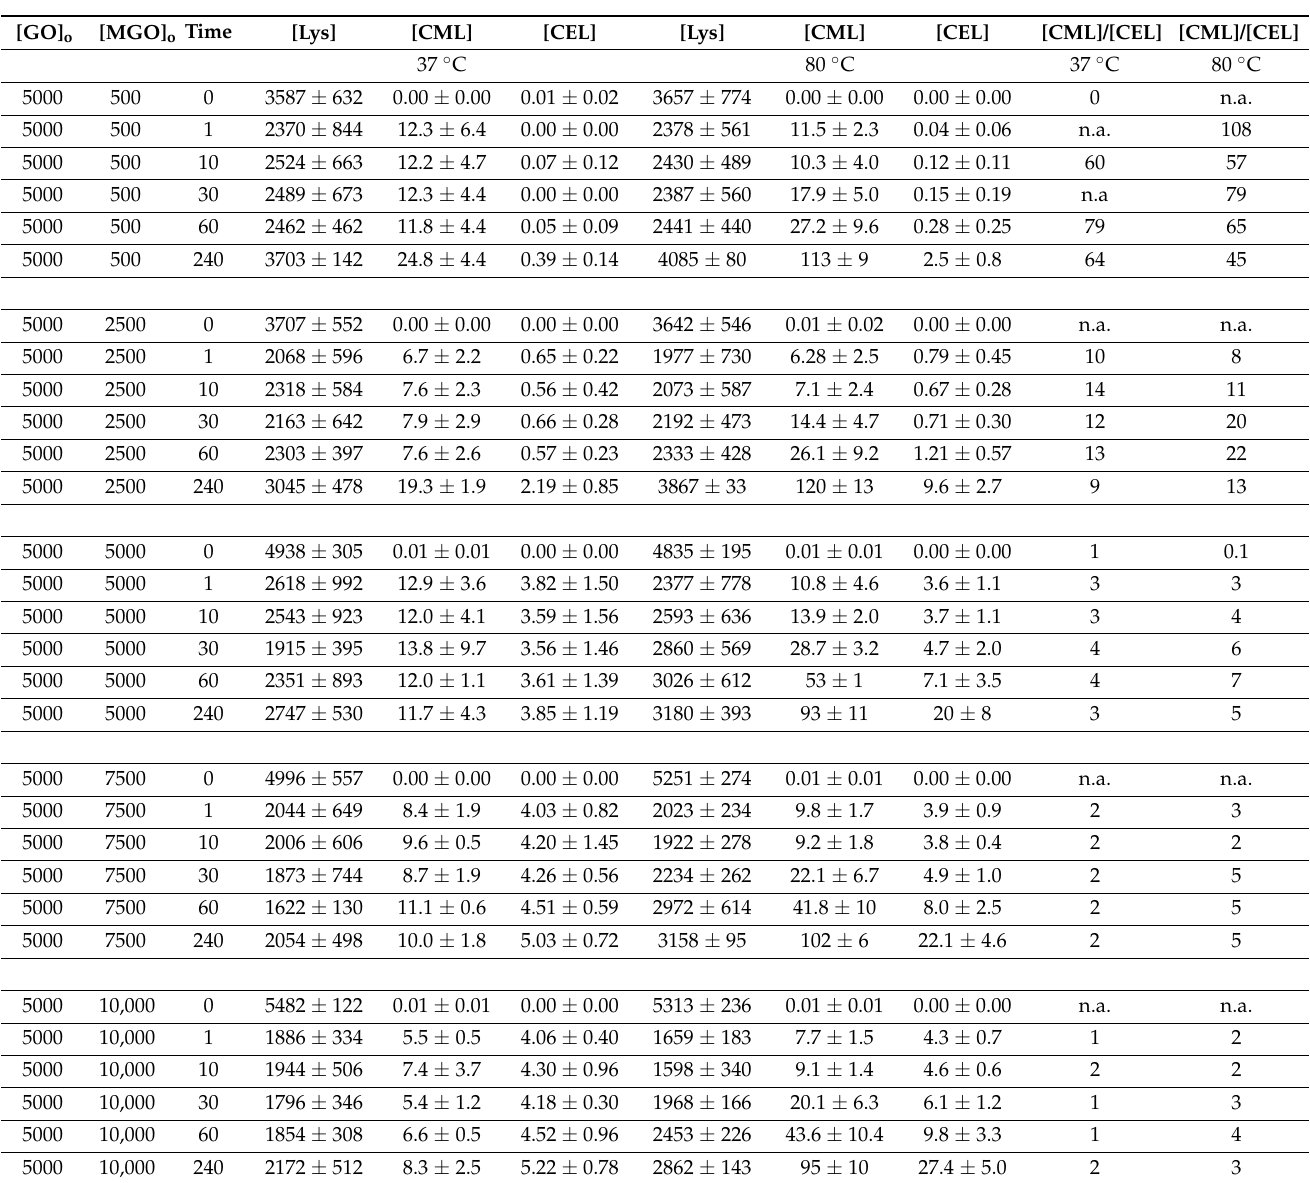
Table 6. Concentration (mean ± SD; µ M) of remaining Lys and formed CML and CEL from the reaction of Lys (5000 µ M) with GO (5000 µ M) and MGO (500–10,000 µ M), respectively, at 37 ◦ C and at 80 ◦ C for the indicated times (min) in 100 mM phosphate buffer (pH 7.4), and molar ratios of CML and CEL. n.a., not